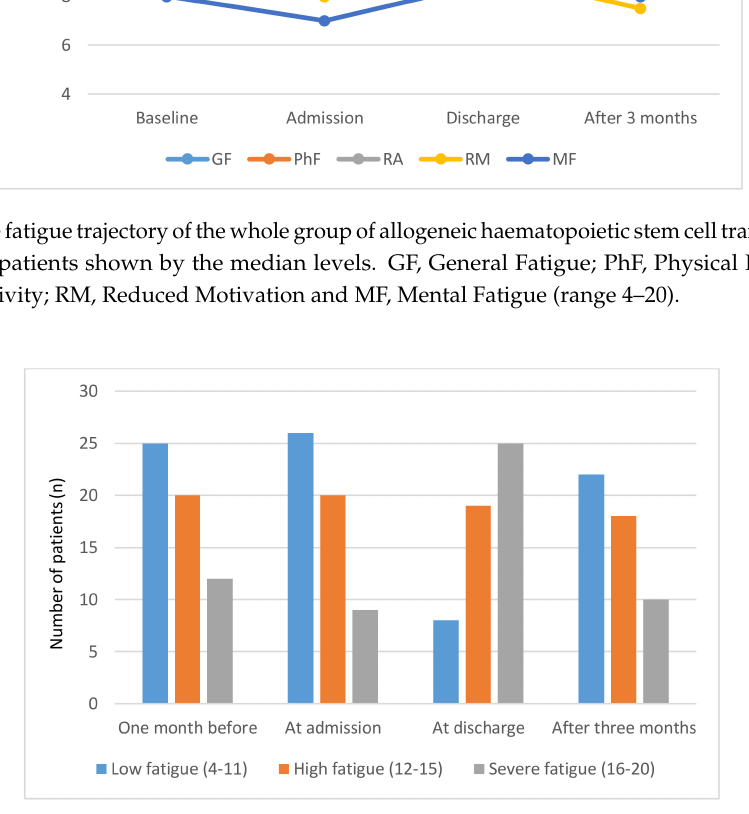
Figure 2. Proportions of the number of patients with low, high or severe fatigue at the di ff erent measurements